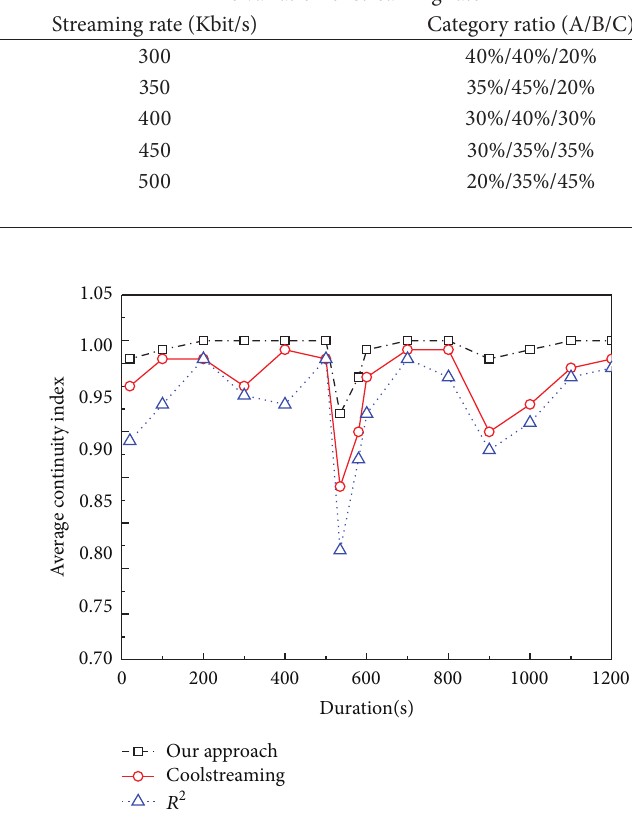
Figure 7: Average continuity index versus simulation